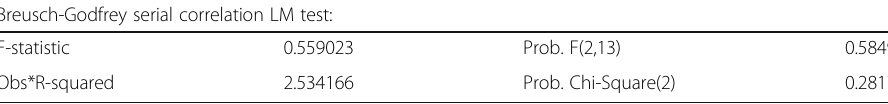
Table 8 Serial correlation test Breusch-Godfrey serial correlation LM test: